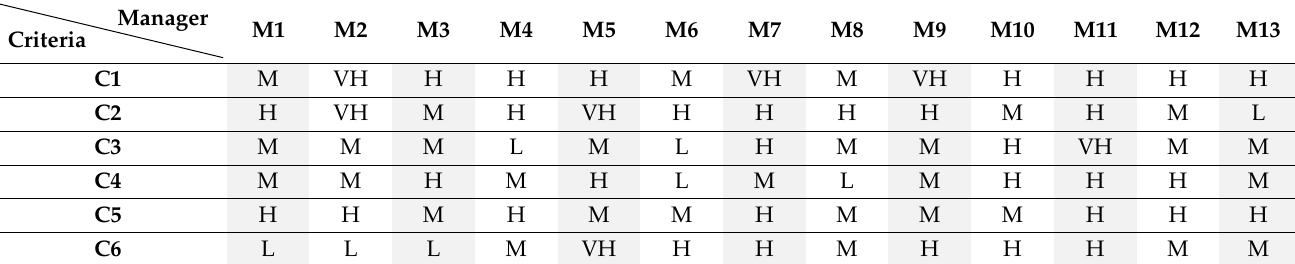
Table 9. The Bryson model evaluation based on the criteria.